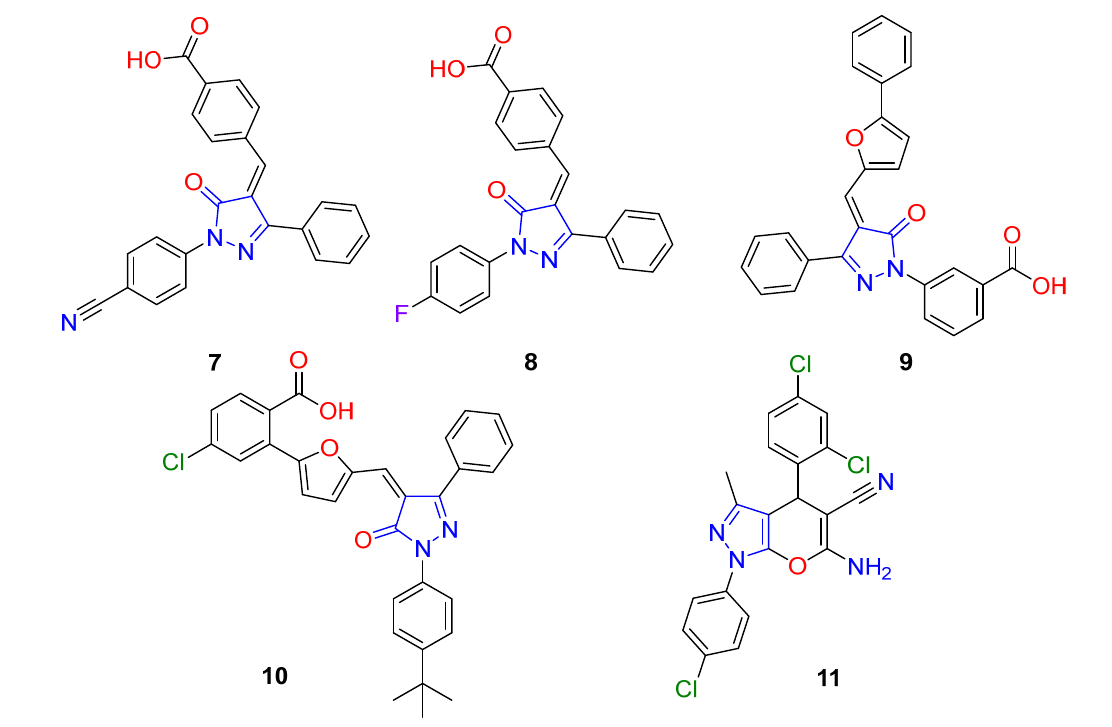
Figure 2. Pyrazolone-incorporating antiviral agents.